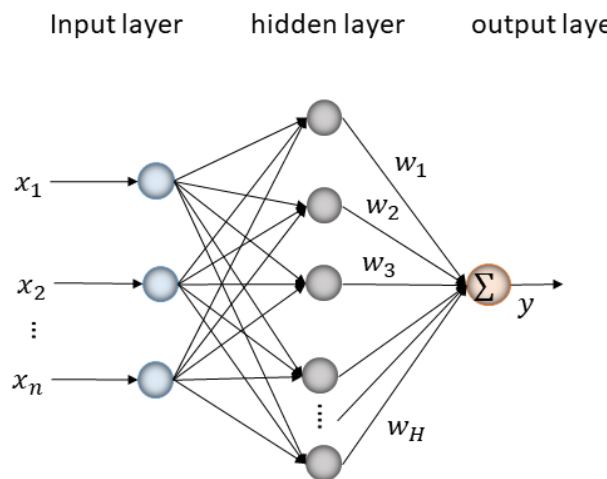
Figure 2. The multi-layer architecture of RBFNN algorithms comprises an input layer, hidden layer, and output